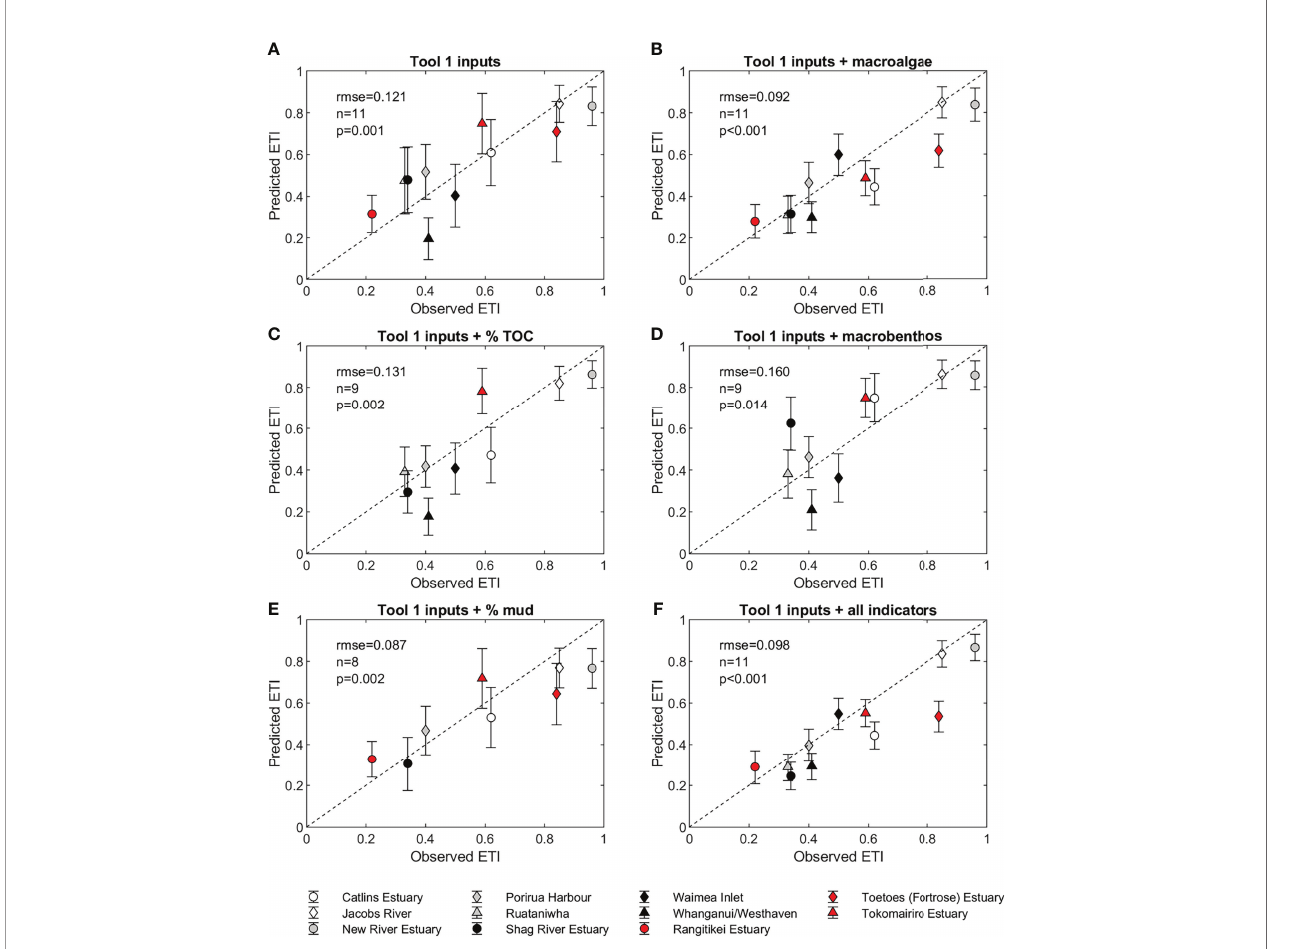
FIGURE 4 | Comparison of ETI Tool 2 scores from observations and scores predicted by the ETI Tool 3 BBN using (A) only driver node data (predicted by ETI Tool 1), and with the addition of observed (B) macroalgal EQR, (C) sediment % TOC, (D) NZ AMBI, (E) average % mud content, and (F) EQR + % TOC + % mud + NZ AMBI. Shown are the root mean squared error (rmse) and error bars showing the standard deviation of the predicted BBN score. Estuaries were not shown in (C – E) when their additional secondary indicator observations were not